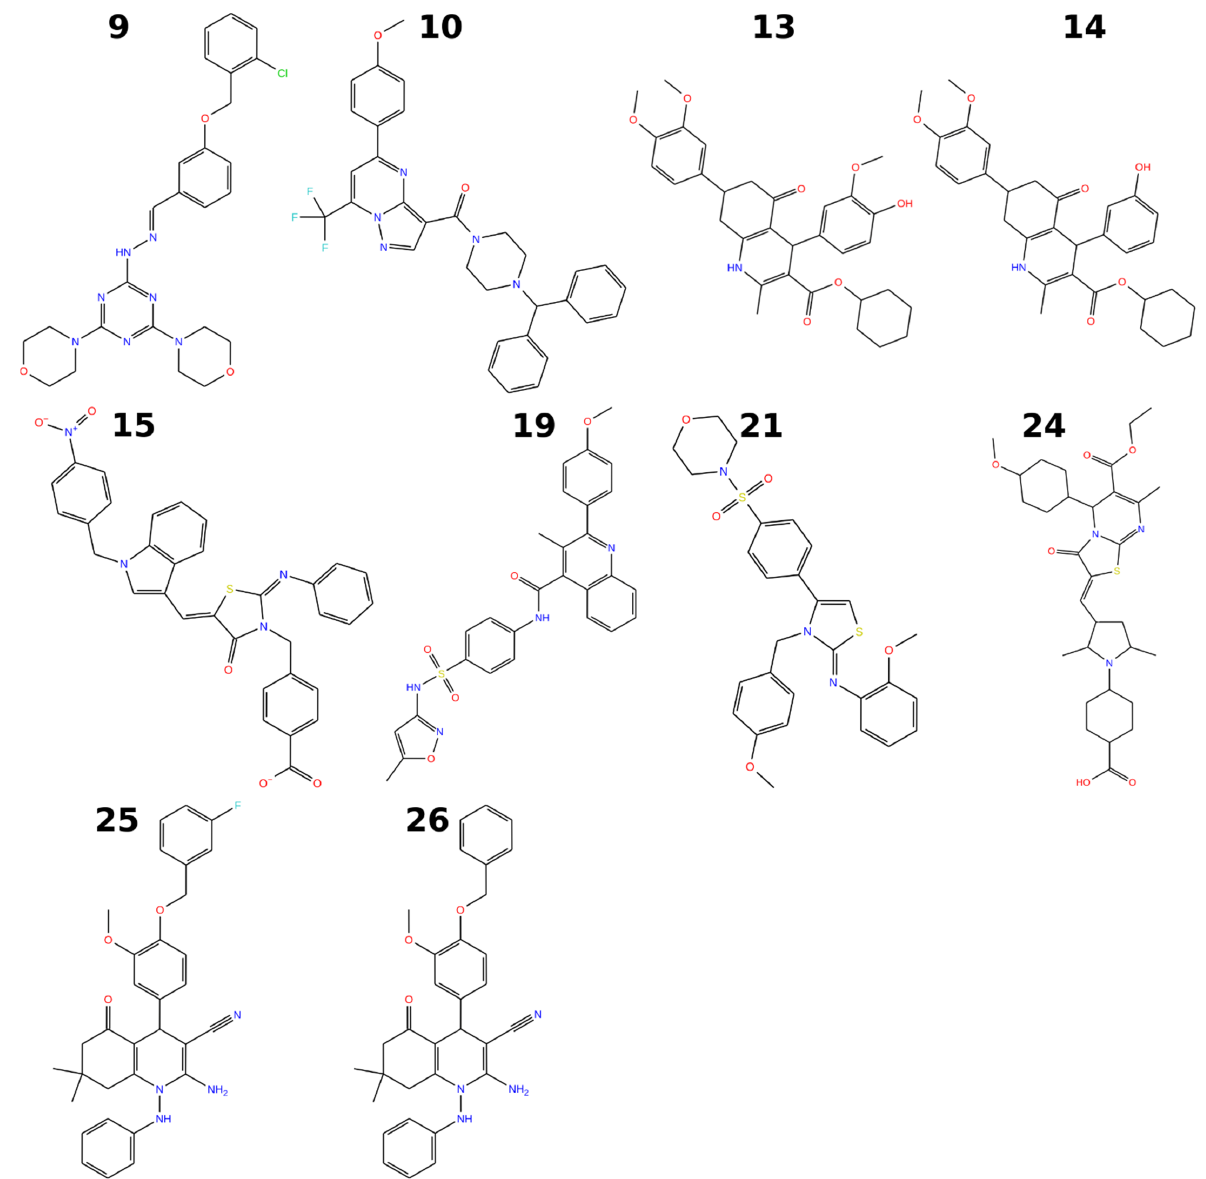
Figure 7. 2D figures for the ROR γ t inverse agonists tested in this study. Figures are shown for the active compounds: 9 , 10 , 13 – 15 , 19 , 21 , and 24 – 26 . Physicochemical and ADMET properties were calculated for the eight compounds